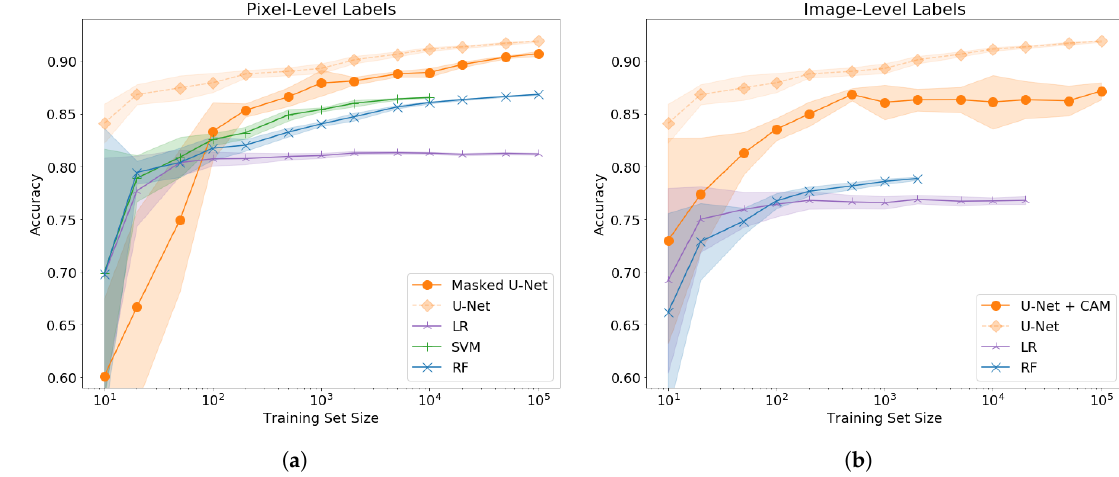
Figure 6. Test set cropland segmentation accuracy versus training set size given ( a ) single pixel labels and ( b ) image labels. Baseline methods include logistic regression (LR), support vector machine (SVM), and random forest (RF). Upper bound for the performance of a U-Net architecture is given by the U-Net with fully segmented labels. Deep learning methods shown are ( a ) U-Net trained on masked loss and ( b ) U-Net with class activation map (U-CAM) to transfer image classification to segmentation. Standard errors result from runs on 10 training folds. SVM is not present and RF/LR are not shown for large sample sizes in panel ( b ) due to prohibitively large computational runtimes.